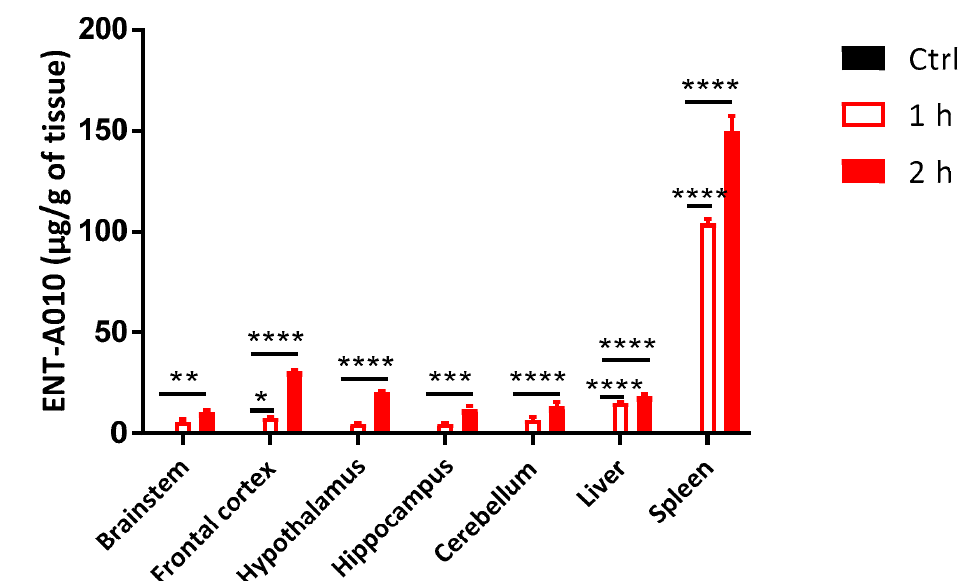
Figure 8. Peripherally administered ENT-A010 is detected in the brain. Mice were i.p. injected with 70 mg/kg ENT-A010 and 1 and 2 h later indicated brain regions, the liver and the spleen were collected, snap-frozen and analyzed by UHPLC-MS. Control mice were injected with the same amount of carrier solution (4.5% ethanol, 1% BSA, PBS). Data are shown as mean ± SEM, n = 3 mice per condition, *: adj p < 0.05 **: adj p < 0.01 ***: adj p < 0.005 ****: adj p < 0.0001.